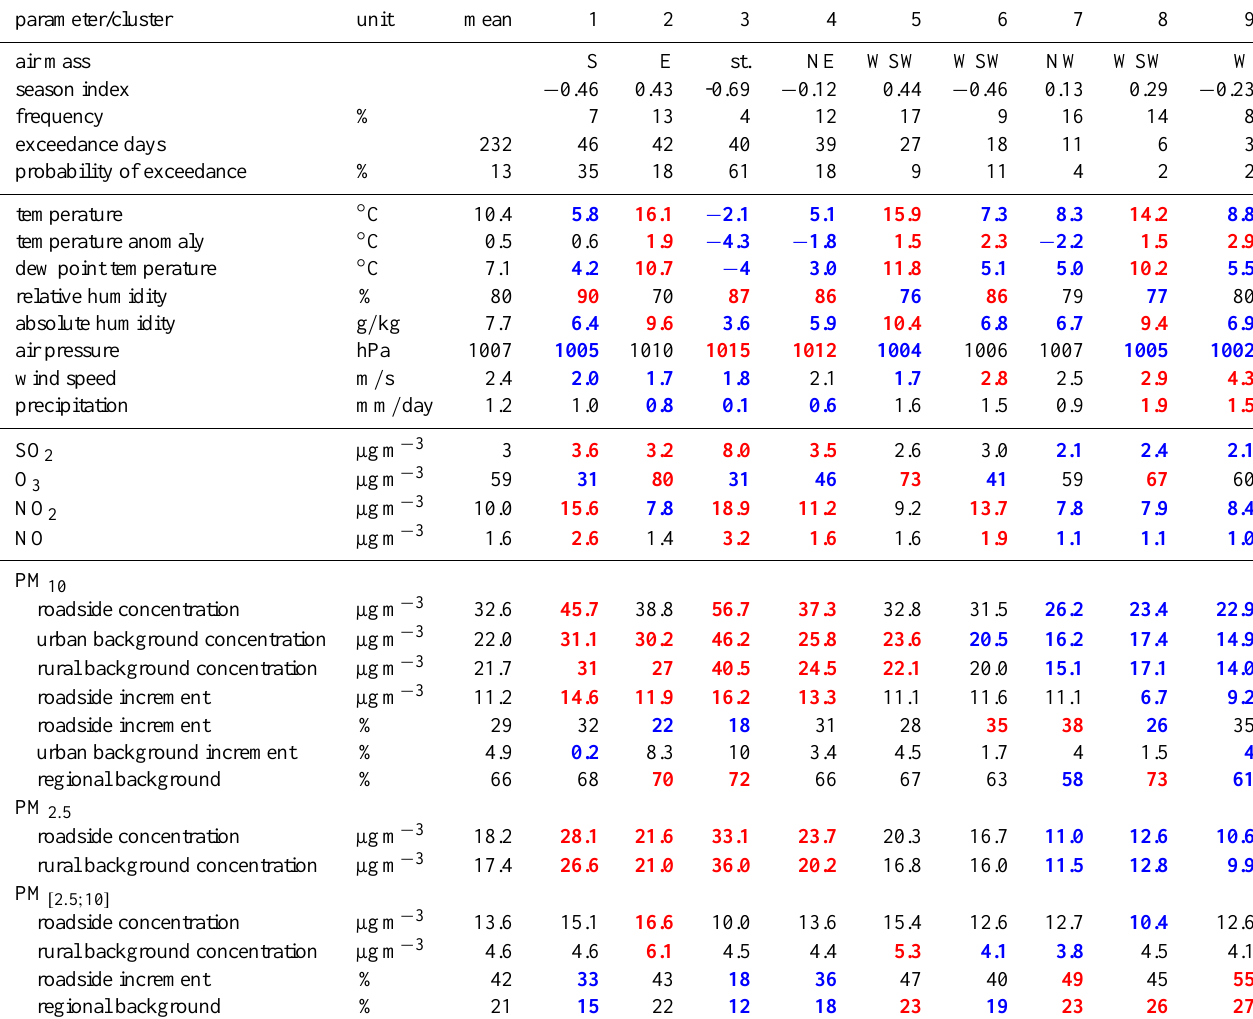
Table 4. Frequency, mean meteorological parameters and trace gas concentrations for each cluster. Bold face indicates clusters where a particular parameter is significantly different from the overall population. Red face indicates significantly higher values, blue face significantly lower values. The temperature anomaly was calculated as the daily mean temperature minus the climatological average temperature for that day of the year. The season index is a number between − 1 (corresponding to midwinter, 21 December) and +1 (midsummer, 21 June), giving an impression of the seasonal distribution of a particular